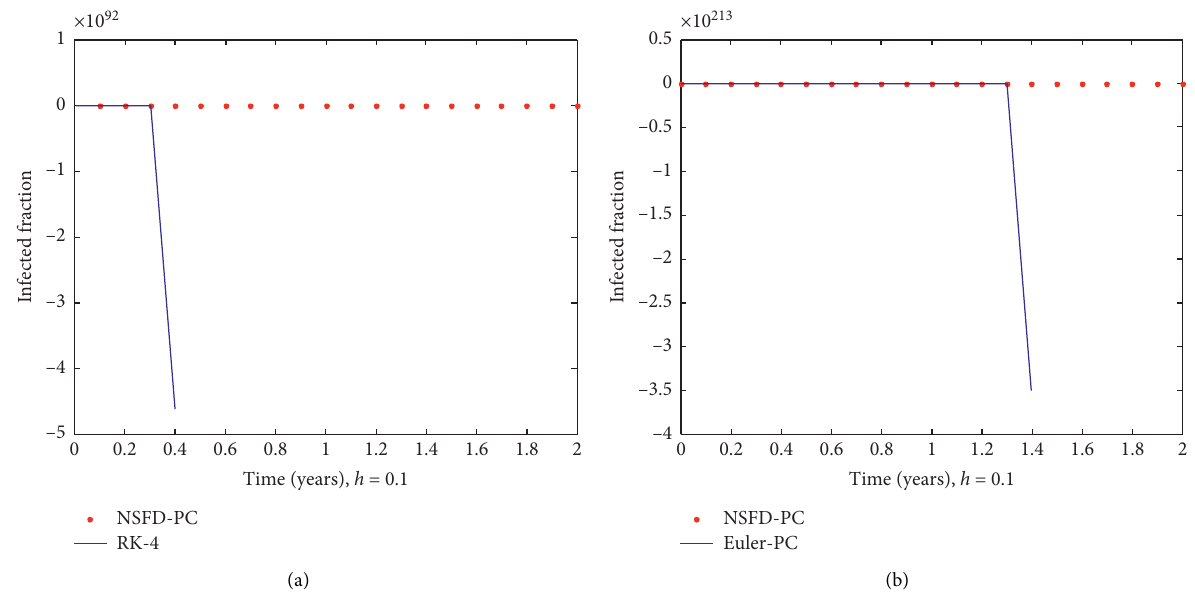
Figure 9: Comparative convergence graphs of the NSFDPC